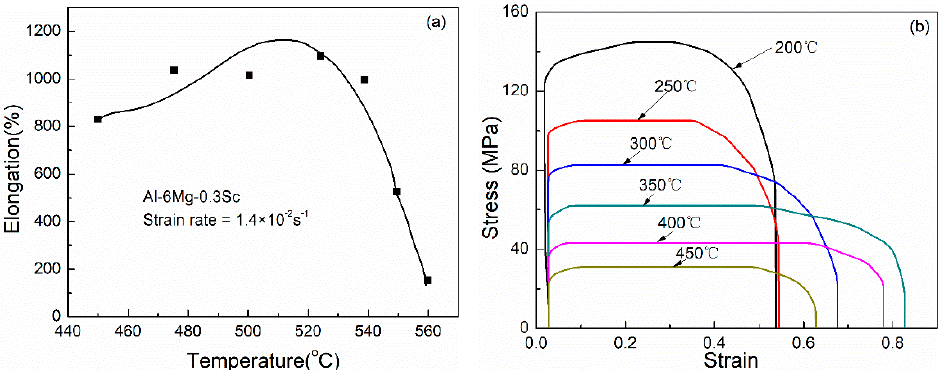
Figure 3. ( a ) Relation between temperature and elongation to failure Al-6Mg-0.3Sc (Left) reproduced from [70], with permission from Elsevier, 1998; ( b ) True stress-true strain curves at different temperatures for the overaged 7075 alloy, reproduced from [51], with permission from Elsevier, 2017.